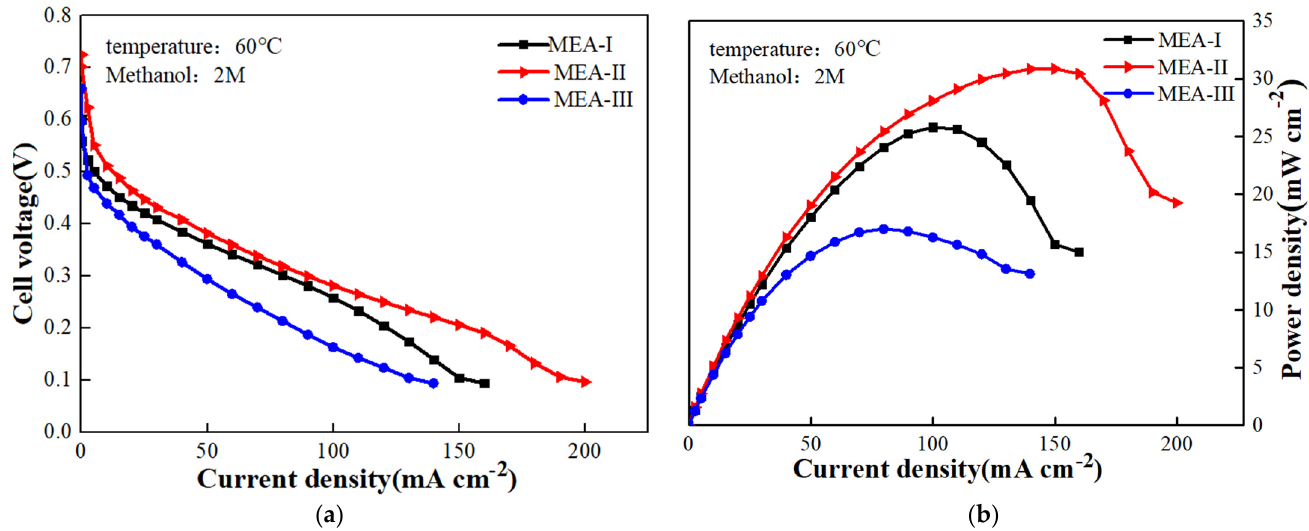
Figure 5. Comparison of the performance of DMFCs with different catalyst loading electrodes. ( a ) Polarization curves; ( b ) power density curves.